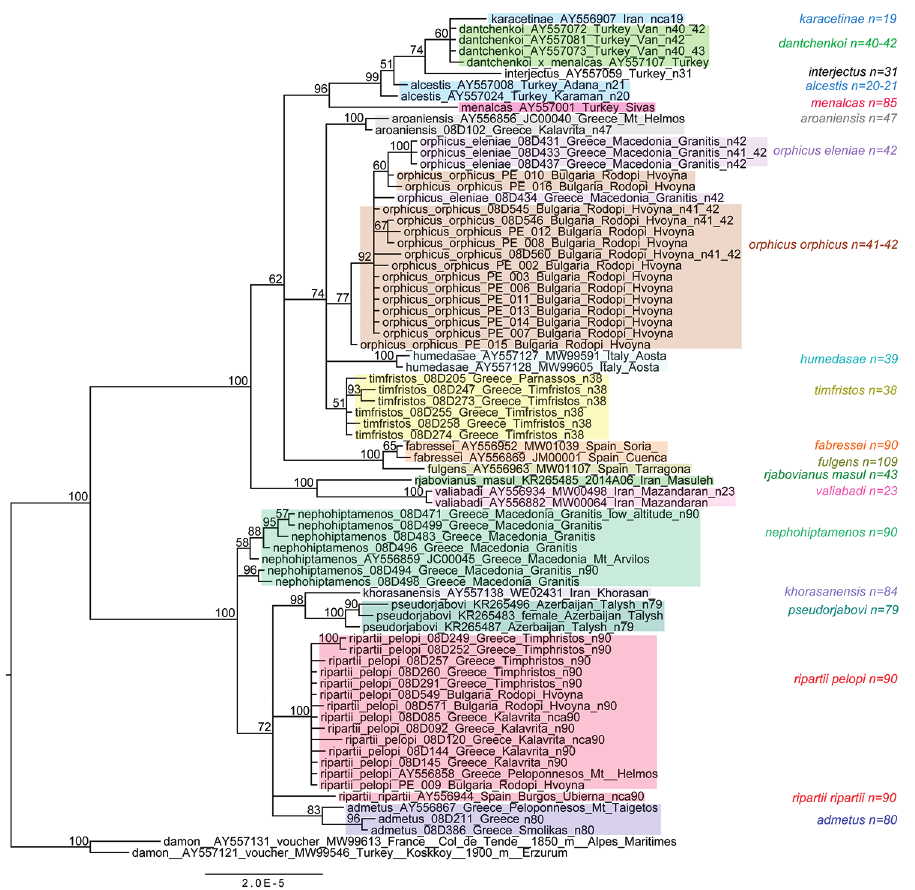
Figure 9. Bayesian tree of P.admetus and P. dolus complexes based on analysis of concatenated alignment ( COI + ITS2 ). Numbers at nodes indicate Bayesian posterior